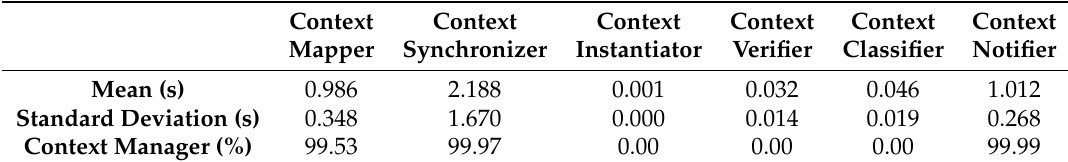
Table 2. Mean and standard deviation of the processing time invested by each of the HLCA components in the context identification, as well as the percentage of these times devoted to the interaction with the Context